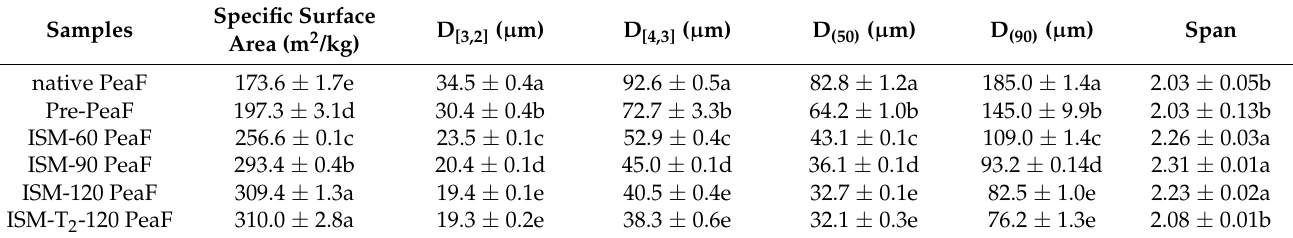
Table 1. Particle diameter size of ISMS-treated PeaF 1